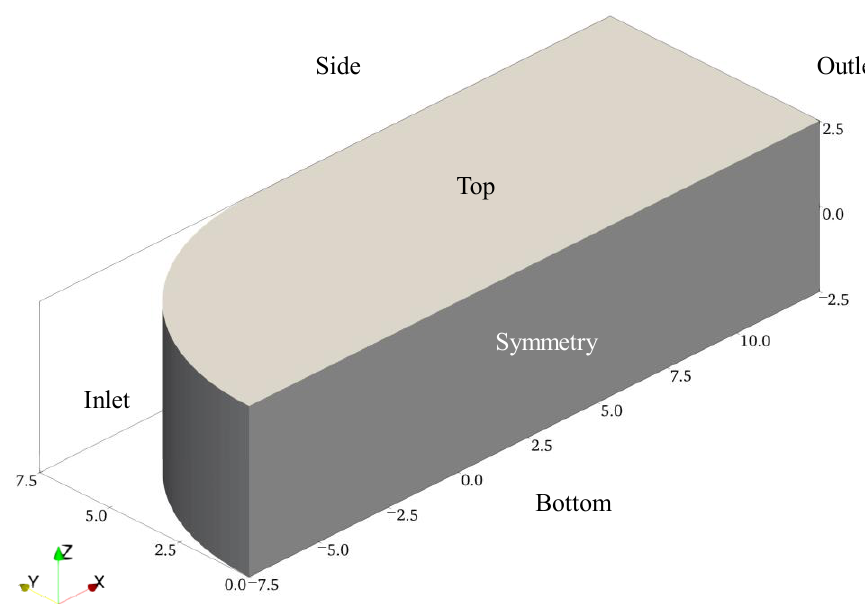
Figure 4. Domain extent and boundary condition of a bull’s-eye waves simulation.